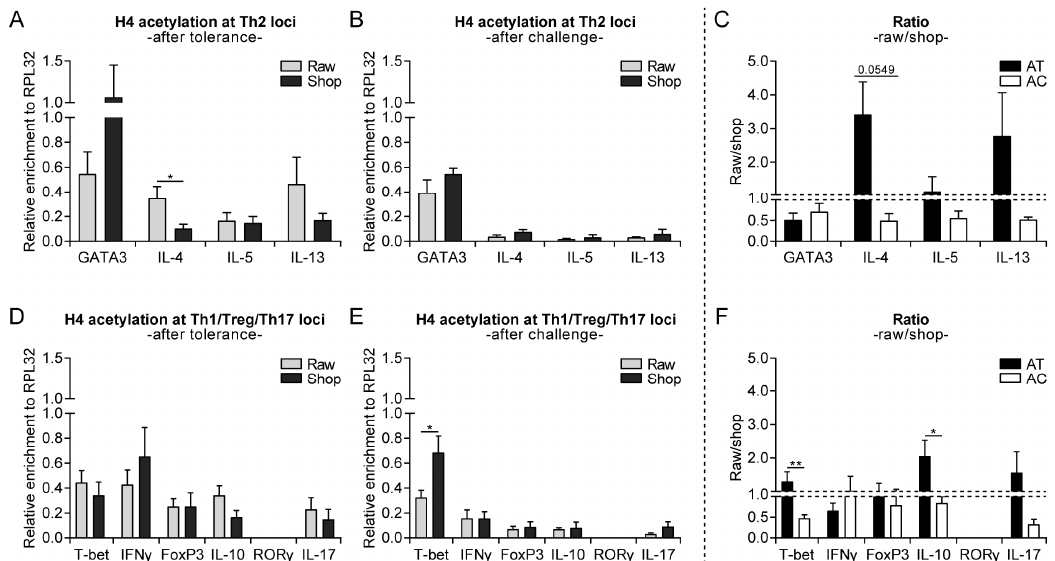
Figure 5. Raw milk-induced acetylation pattern of Th2-related genes observed in splenocyte-derived CD4 + T cells also visible locally in mesenteric lymph nodes (MLN). ( A ) Histone H4 acetylation at Th2 loci after the tolerance induction period (day − 1), ( B ) after both challenges (day 34) and ( C ) the raw milk/shop milk ratio. ( D ) Histone H4 acetylation at Th1/Treg/Th17 loci after the tolerance induction period (day − 1), ( E ) after both challenges (day 34) and ( F ) the raw milk/shop milk ratio. Histone H4 acetylation status was determined by means of chromatin immunoprecipitation in MLN of raw milk- and shop milk-treated mice. The results are expressed as relative enrichment after normalization to ribosomal protein L32 (RPL32) as mean ± standard error of the mean, n = 4–6 / group. * p < 0.05, ** p < 0.01 as analyzed with an unpaired two-tailed Student’s t -test. A Mann–Whitney test was used for GATA3, IL-10 (after tolerance), IL-10 (after model) and GATA3 (ratio raw / shop) since data did not obtain normality. Raw, raw cow’s milk; shop, shop milk; AT, after tolerance; AC, after challenge; MLN; mesenteric lymph nodes.